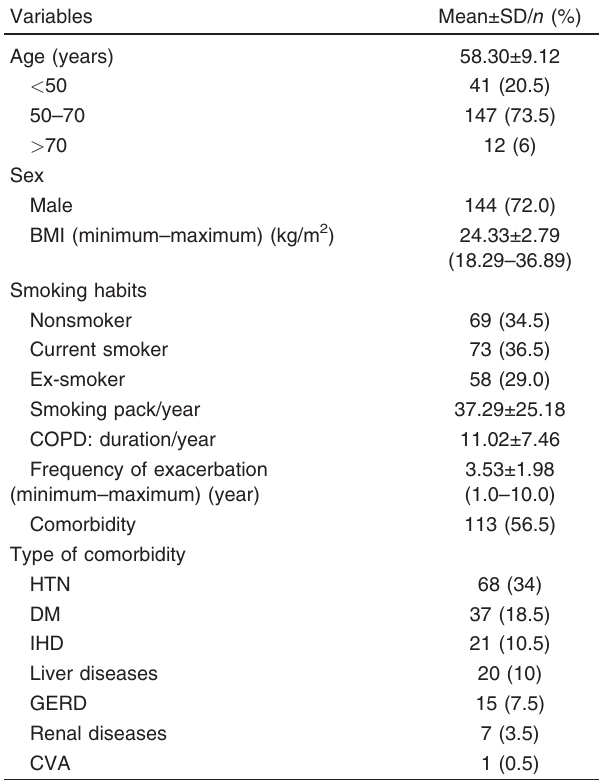
Table 1 Demographic and clinical data of the studied chronic obstructive pulmonary disease